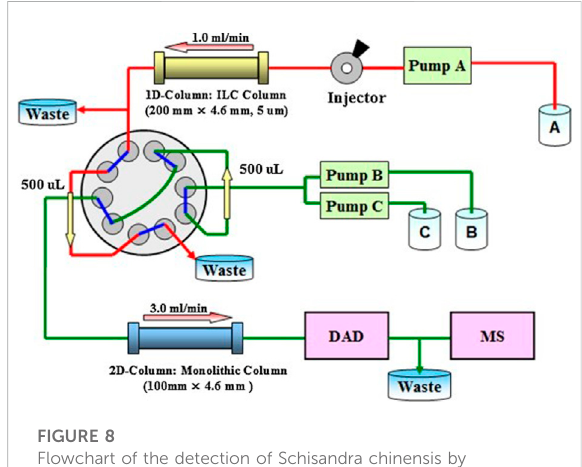
FIGURE 8 Flowchart of the detection of Schisandra chinensis